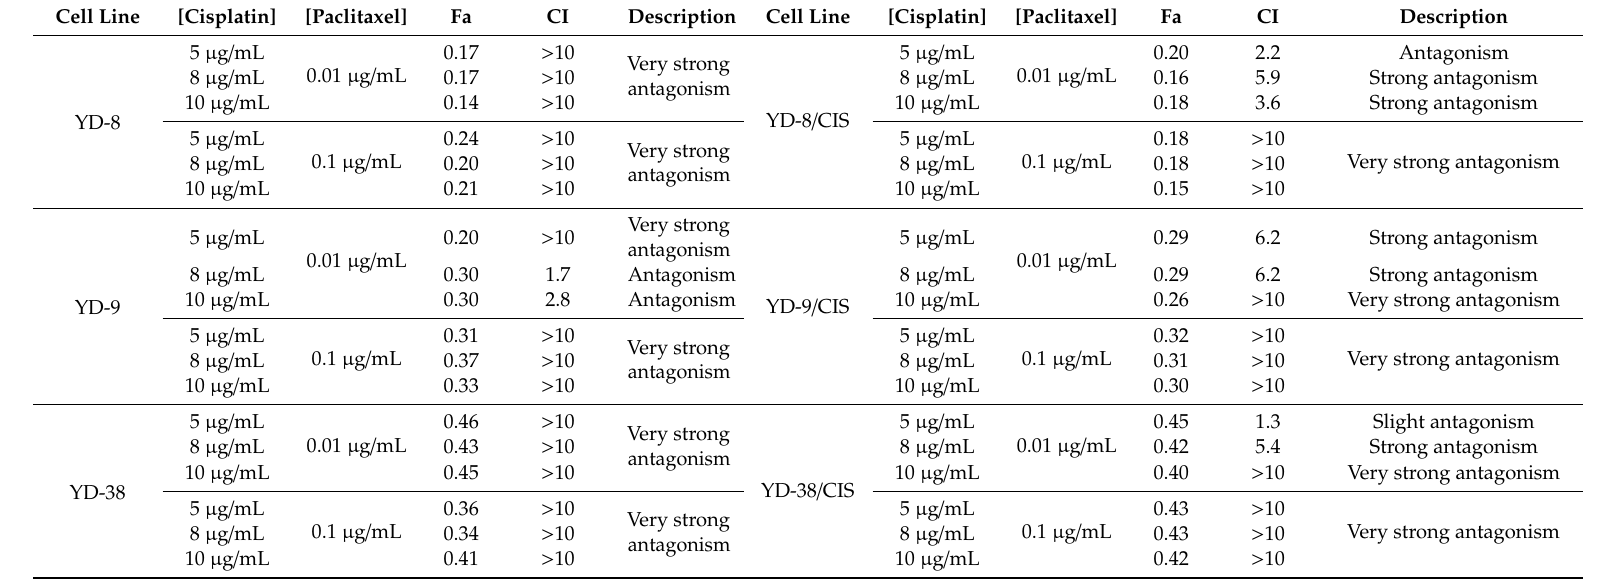
Table 2. CI analysis of cisplatin combined with paclitaxel used to treat OSCC